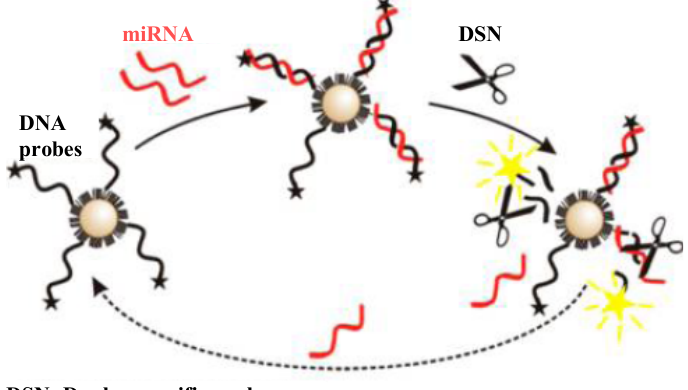
Figure 4. Assay strategy. Reprinted with permission from [34]. Copyright 2014 American Chemical